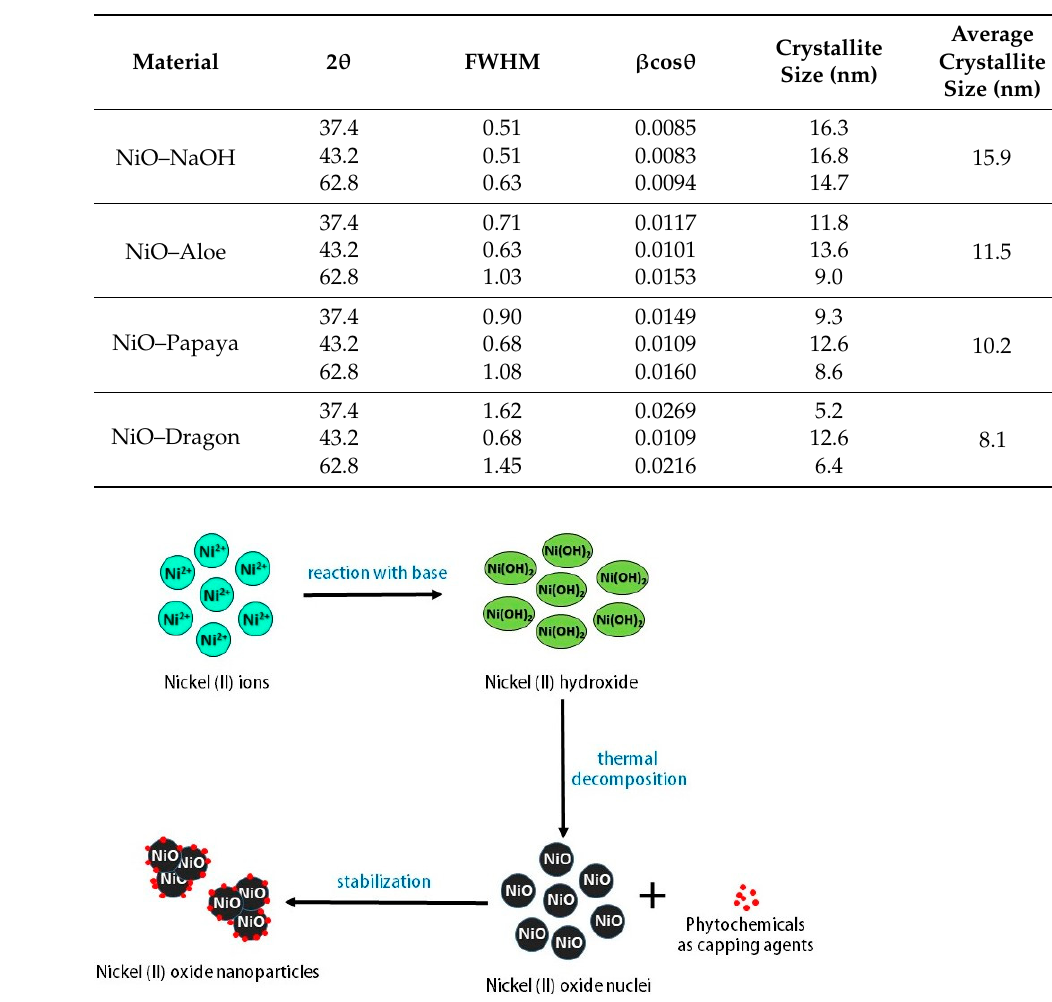
Figure 2. Plausible mechanism for green synthesis of NiOx